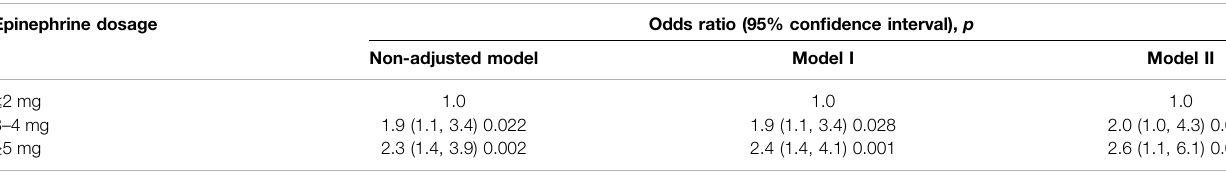
TABLE 3 | Multivariate logistic regression